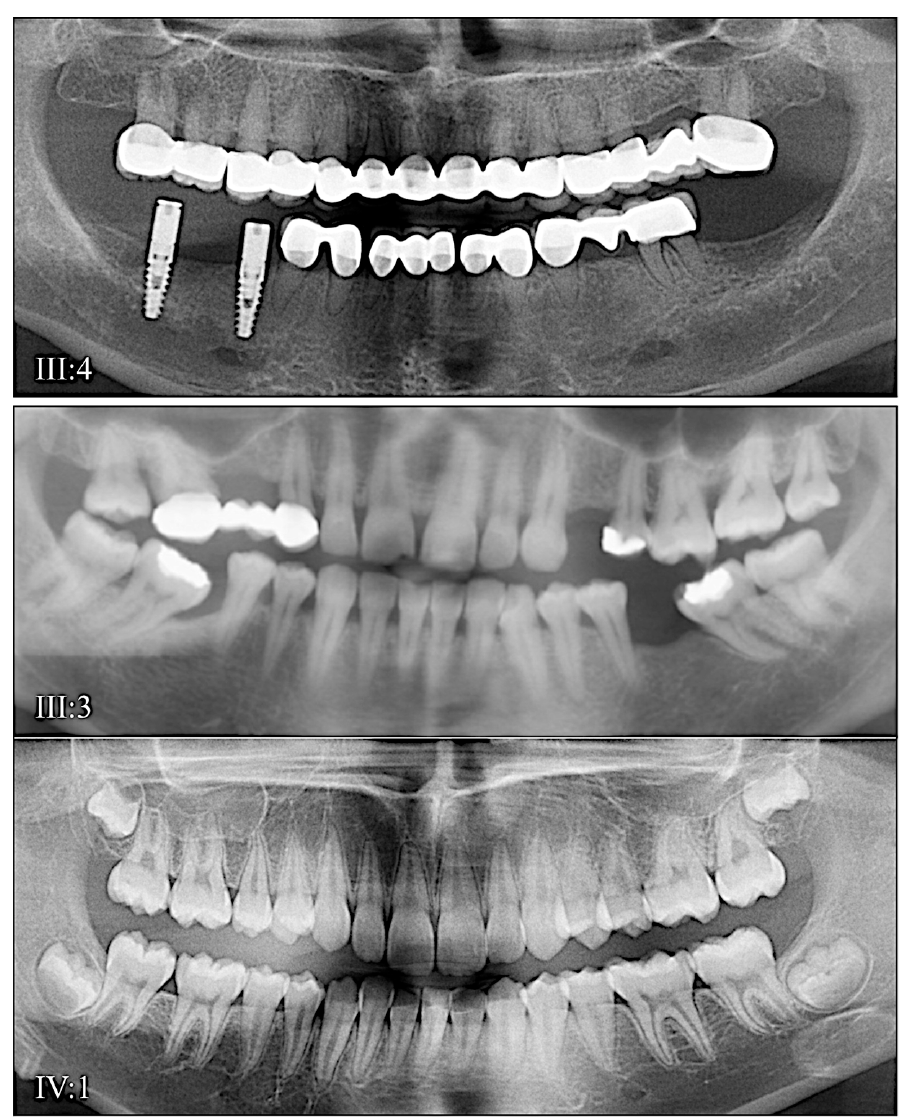
Figure 4. Family 2 Panorex Radiographs. The affected mother (III:4) had short roots with obliterated pulp chambers, whereas the unaffected father (III:3) and younger sister (IV:1) show normal dentitions. Family 3 is from Taiwan (Figure 5). The proband (IV:2) at 12-years 1-month presented with amber-brown teeth with bulbous crowns that had severe attrition associated with first molar abscesses (#14, #20, and #29) and loss of vertical dimension accelerating attrition of the anterior teeth (Figure 5A,B). The permanent tooth roots were generally short, and their pulp chambers obliterated (Figure 5B). A single allele DSPP defect (NM_014208.3: c.53T>C; p.Val18Ala) altering the second nucleotide of exon 3 was identified by WES analysis of DNA from the proband (IV:2) and her affected mother (III:2), and then confirmed by Sanger sequencing (Figure 5C). The four-generation pedigree, provided by the mother, confirmed the dominant pattern of inheritance (Figure 5D). This DSPP mutation is novel and has a Polyphen2 score of 0.998 [95]. Other missense mutations in the Val18 codon have been reported to cause dentinogenesis imperfecta: p.52G>T; p.Val18Phe [54,67,68,70,71] and p.53T>A; p.Val18Asp [72–74]. The affected mother showed long-term effects of this severe condition (Figure